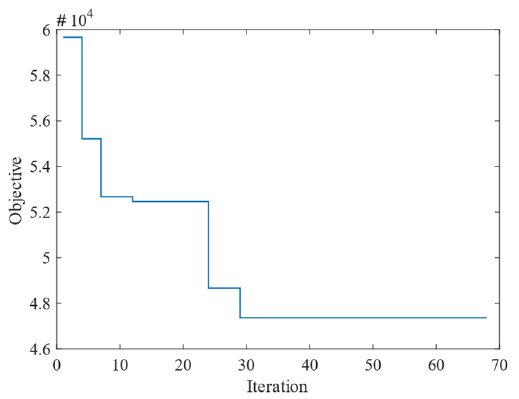
Figure 6. Convergence process of the Lagrangian relaxation algorithm ( |𝐿| = 100 ).